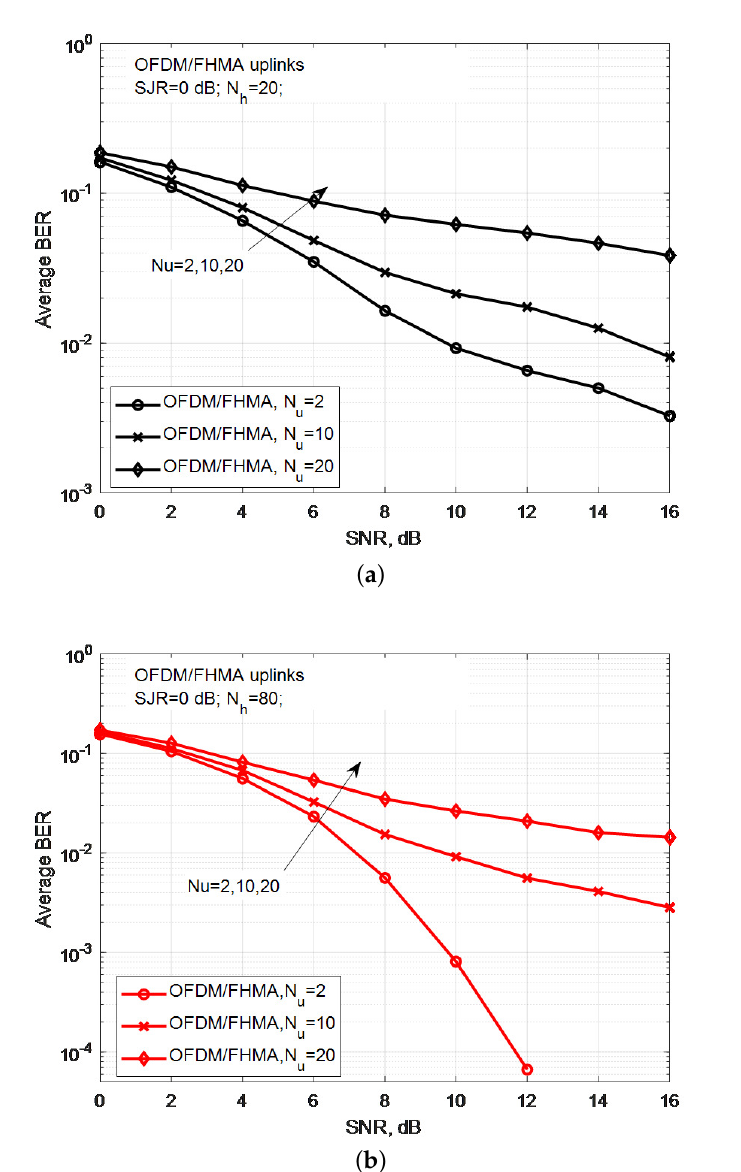
Figure 6. The effects of system capacity ( N u ) and the number of FH frequency slots ( N h ) on the reliability of the proposed OFDM/FHMA (( a ) N h = 20; ( b ) N h = 80 )